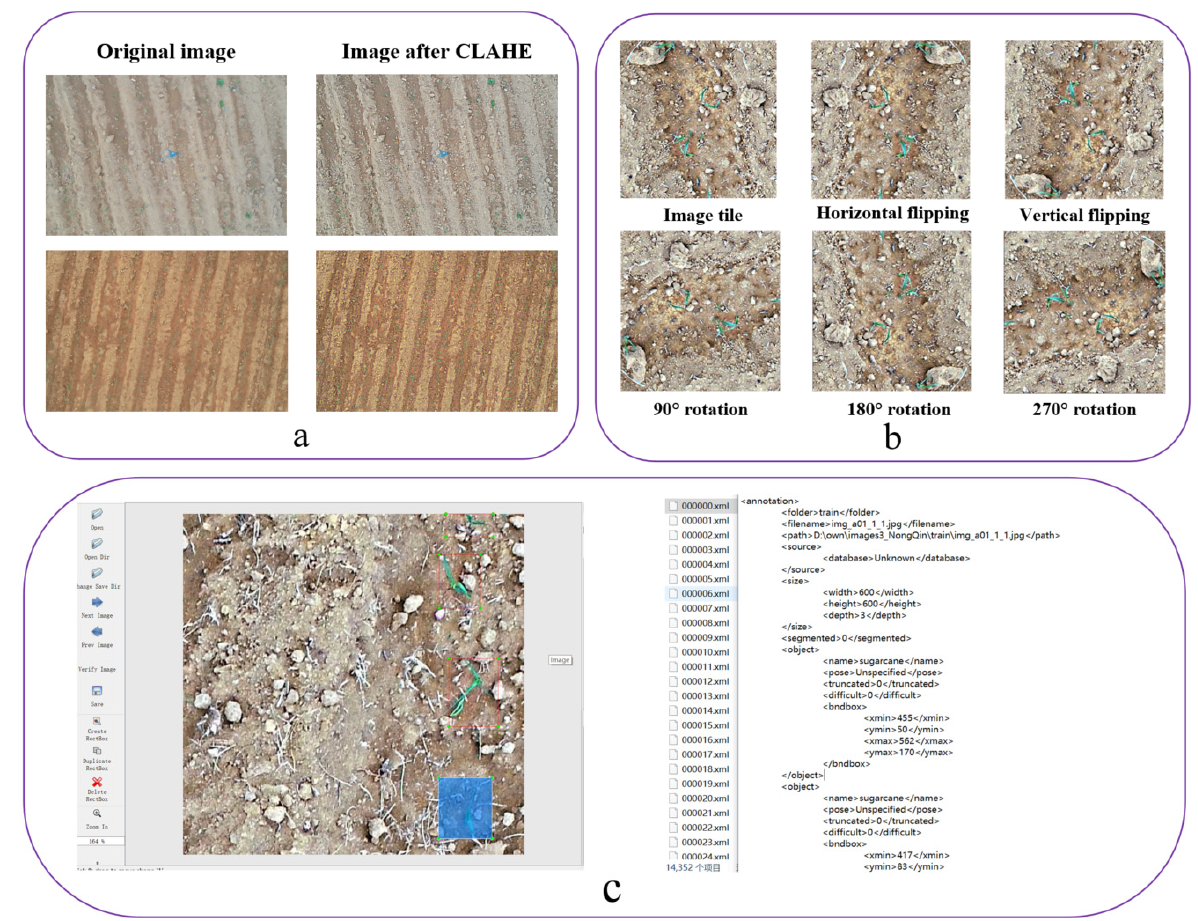
Figure 4. Data preprocessing. ( a ) The CLAHE process. ( b ) Data augmentation. ( c ) Images of sugarcane seedlings with annotations.